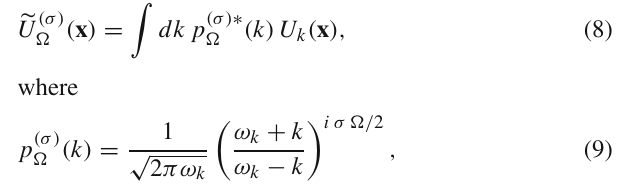
and orthonormality of the set of